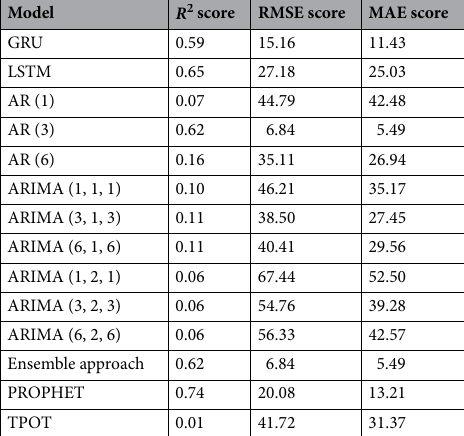
Table 4. 14-day CI accuracy prediction for the second dataset. Training from July 20, 2020 to December 4, 2020, Prediction from December, 5 to December, 18.